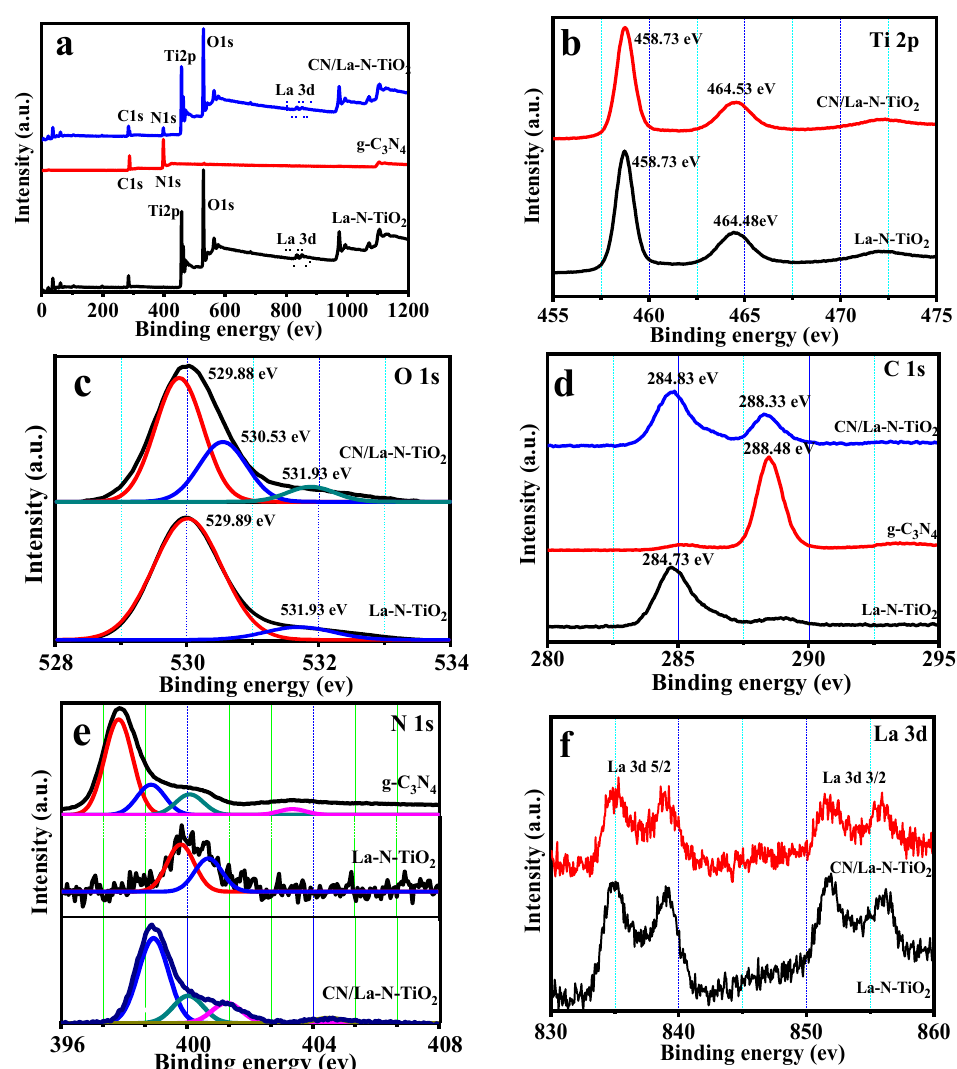
Figure 4. XPS survey spectrum ( a ); high-resolution XPS spectra of Ti 2p ( b ), O 1s ( c ), C 1s ( d ), N 1s ( e ), and La 3d ( f ).